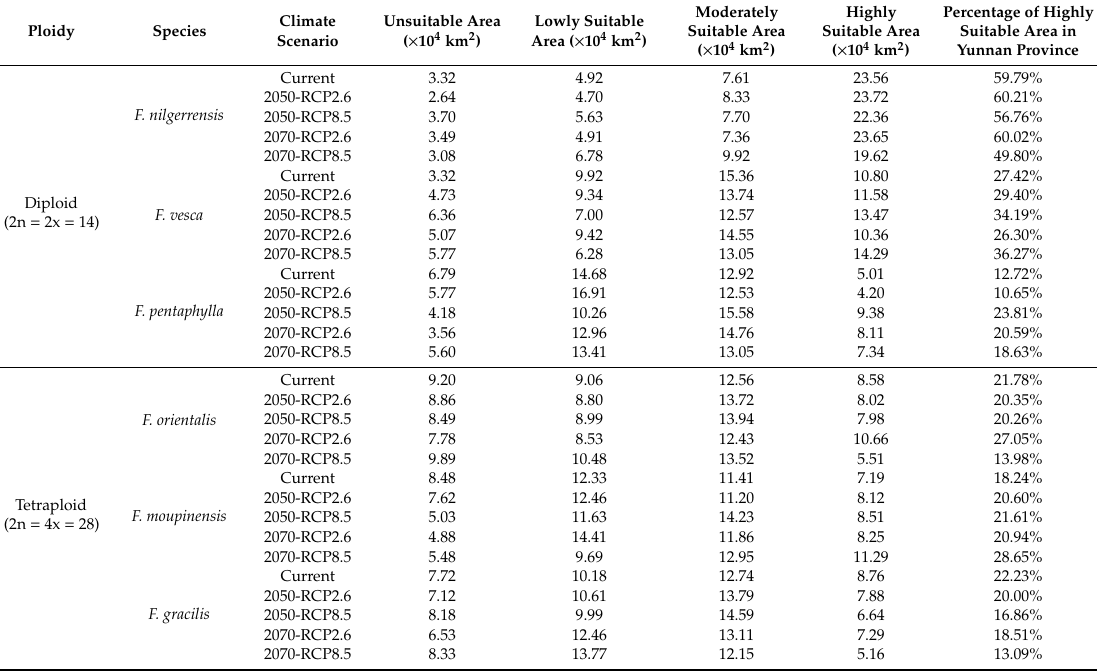
Table 3. Potential distribution areas for six wild strawberry species under five di ff erent climate scenarios. Ploidy